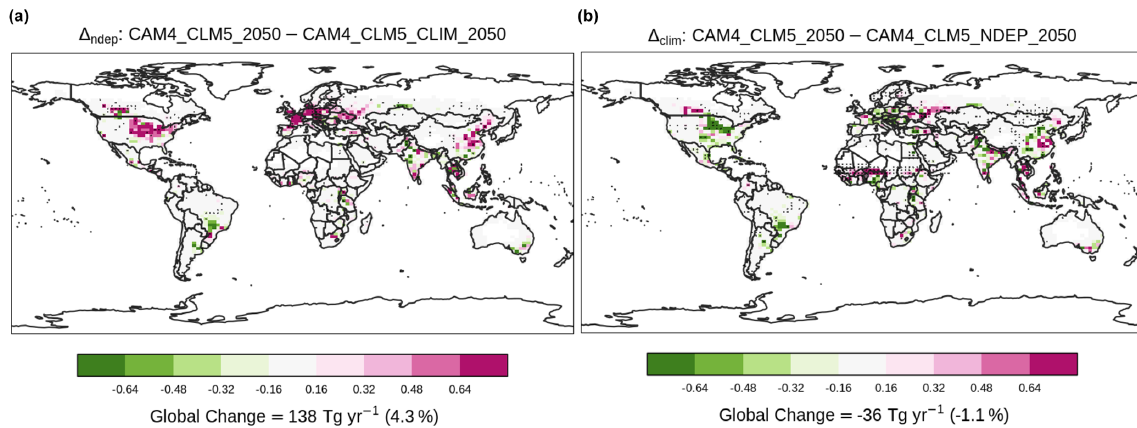
Figure 8. Contrasting the difference in grain production (teragrams of dry matter per year). Overlaying black dots indicate grid cells with a statistically significant difference under two-sample t tests (i.e., p < 0 . 05) between corresponding simulations. Only results of grid cells with croplands are